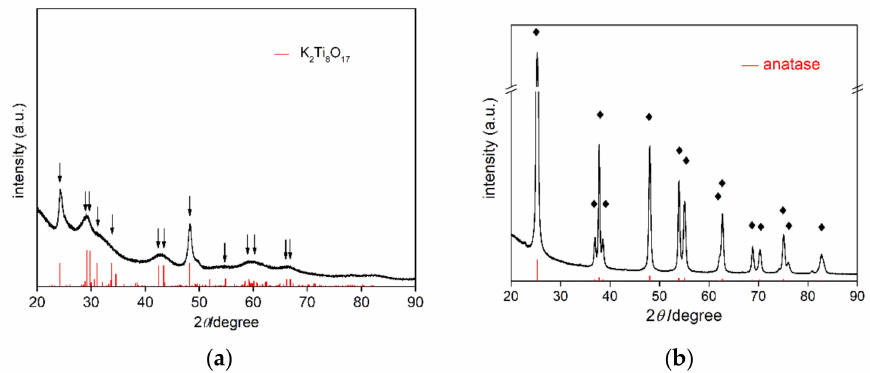
Figure 2. XRD patterns of: ( a ) Bare TNW, and ( b ) bare OAP, with marked K 2 Ti 8 O 17 and anatase peaks, respectively (red patterns from PDF cards No 9874 and No 8214, respectively).